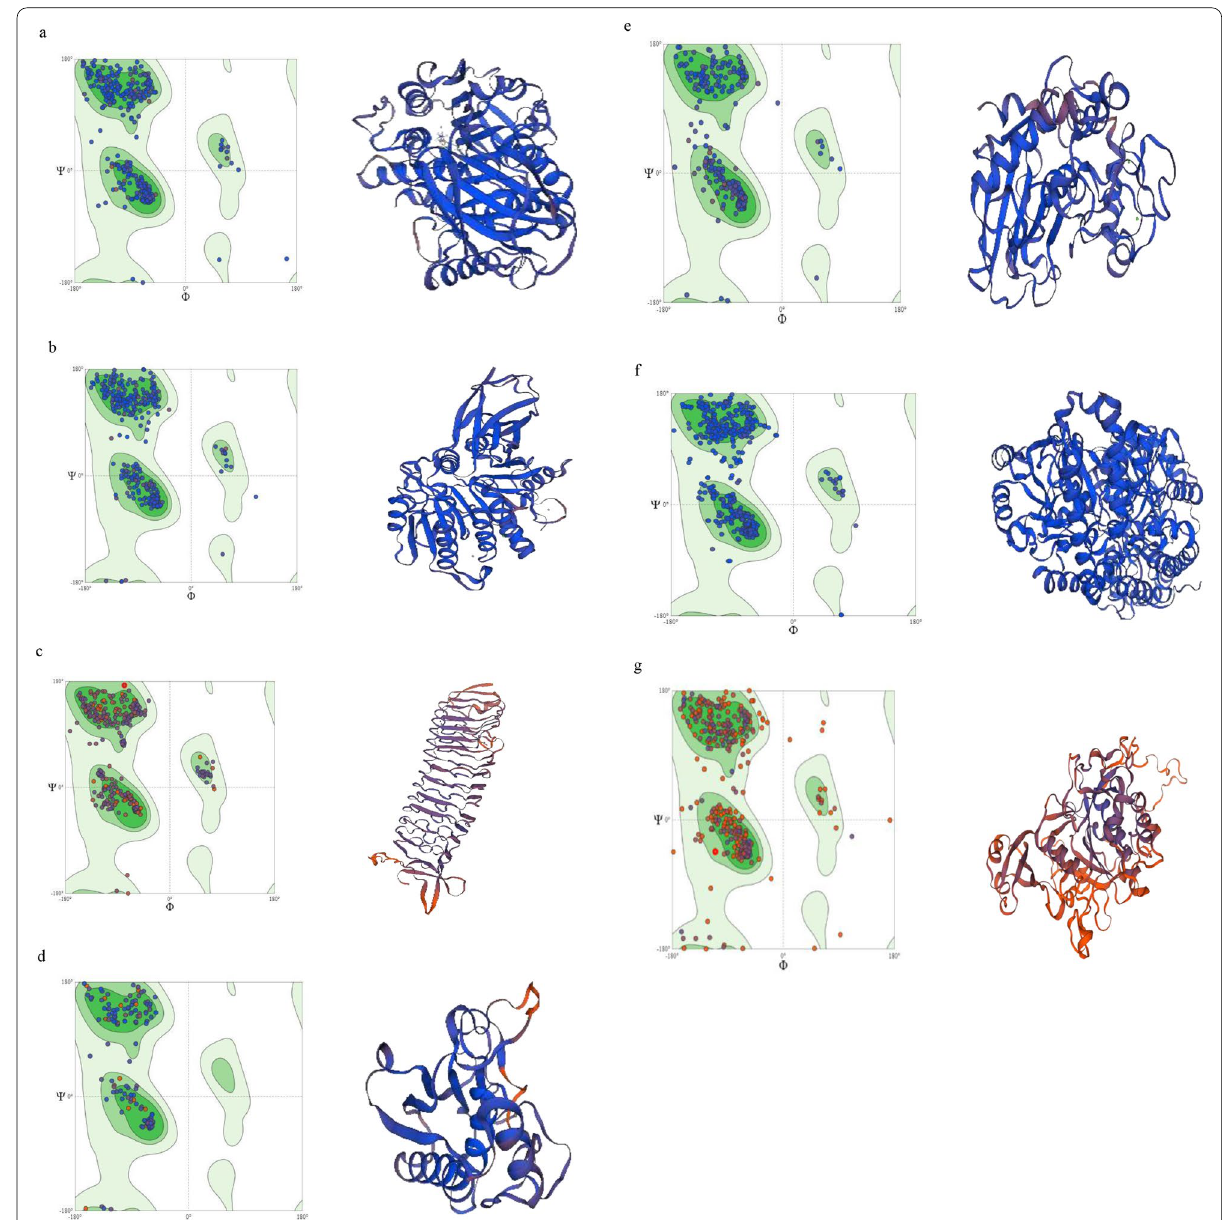
Fig. 6 Ramachandran plots and 3D structures of virulence factors of red complex bacteria: a Gingipain-Kgp, b Gingipain-RgpB, c BspA, d Karilysin, e Mirolysin, f Cystalysin, g